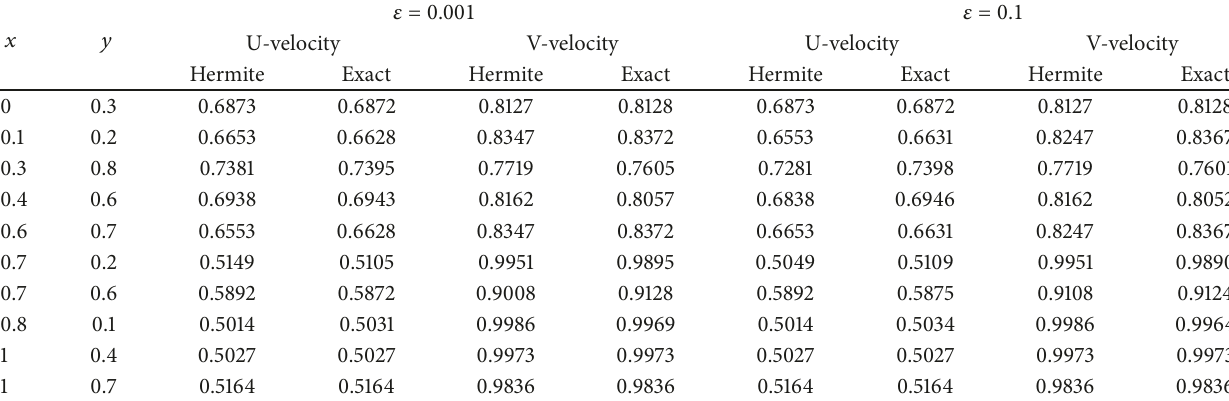
Table 1: Numerical solutions for Re = 50, Δ𝑡 = 0.001 , 𝑡 = 0.5 , and 𝑁 = 12 × 12 .